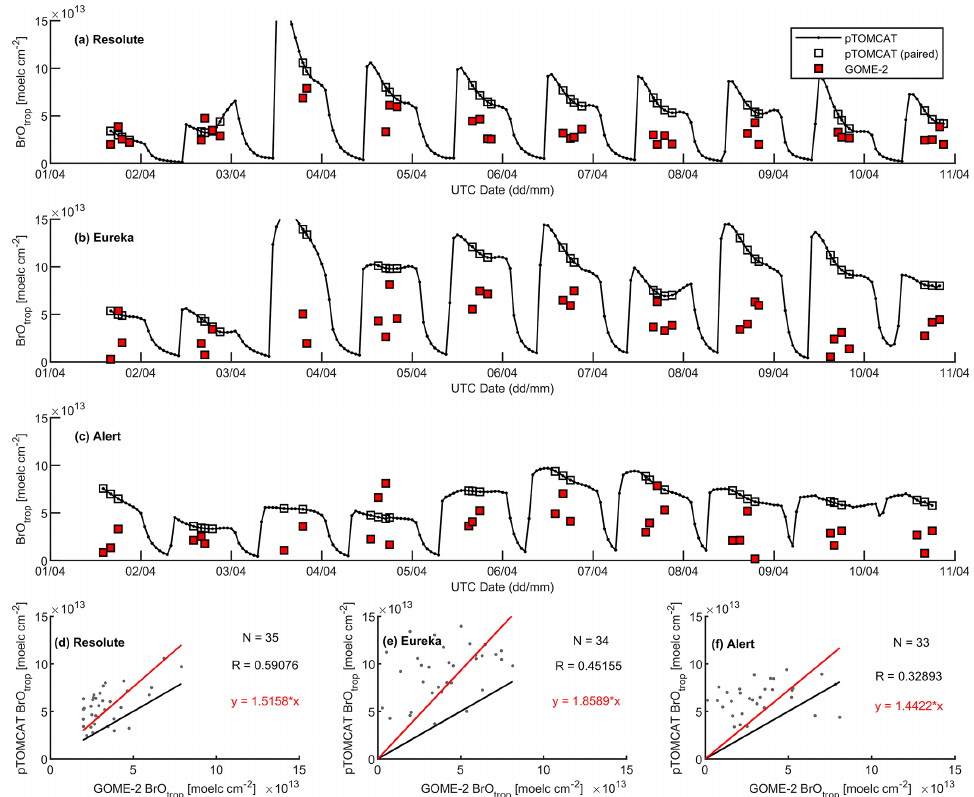
Figure 15. Same as Fig. 14 but for pTOMCAT_control run